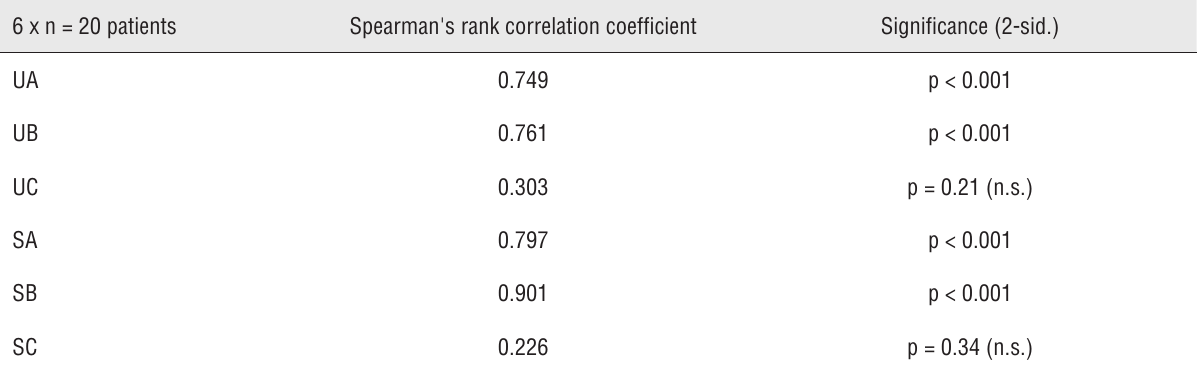
Table 2 - Correlation between CACS and peak NRS. 6 x n = 20